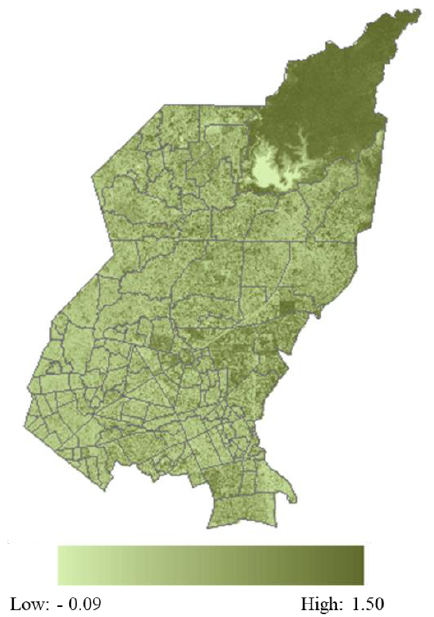
Figure 6. Visible green near infrared built-up index derived from PlanetScope image of Quezon City